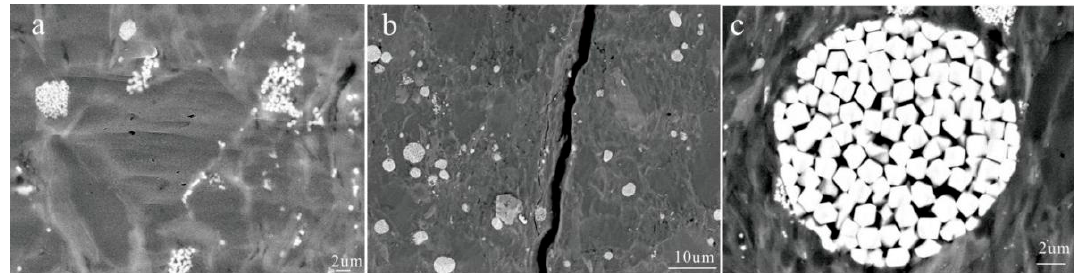
Figure 4. Profiles of Y, SiO 2(exc) and chemical index of alteration (CIA) values from the well ZY5.